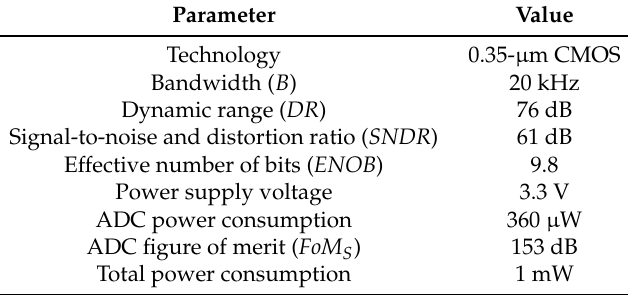
Table 1. Measured performance summary (example 1).